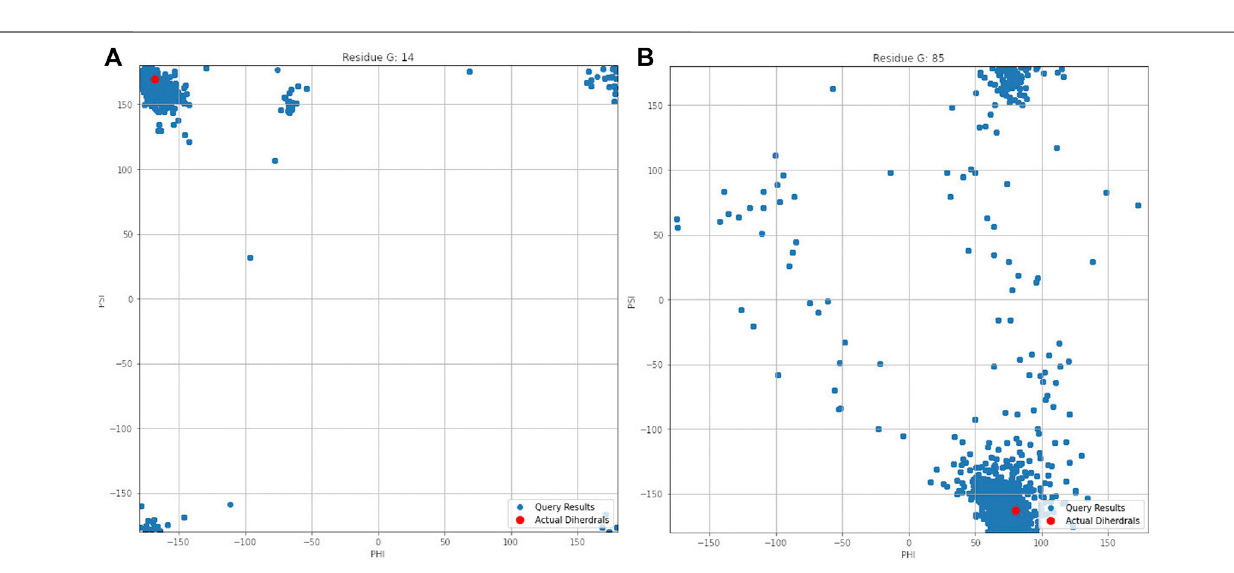
Frontiers in Molecular Biosciences |